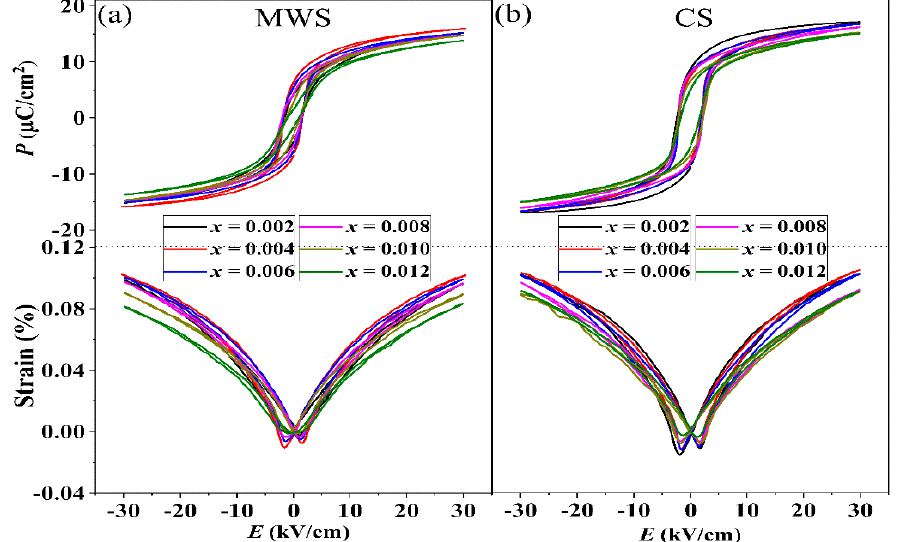
Figure 5. P - E and S - E loops of ( a ) MWS and ( b ) CS sintered BTS-BCT- x BF ceramics.